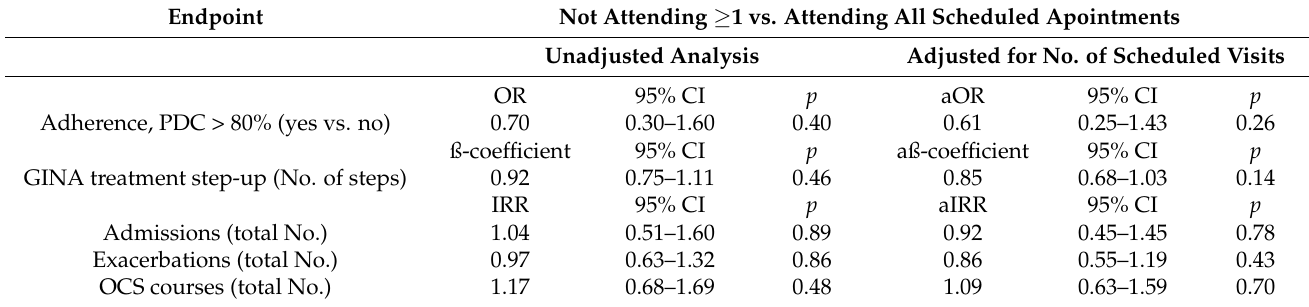
Table 4. Association between non-attendance of scheduled appointments, treatment adherence and loss of asthma